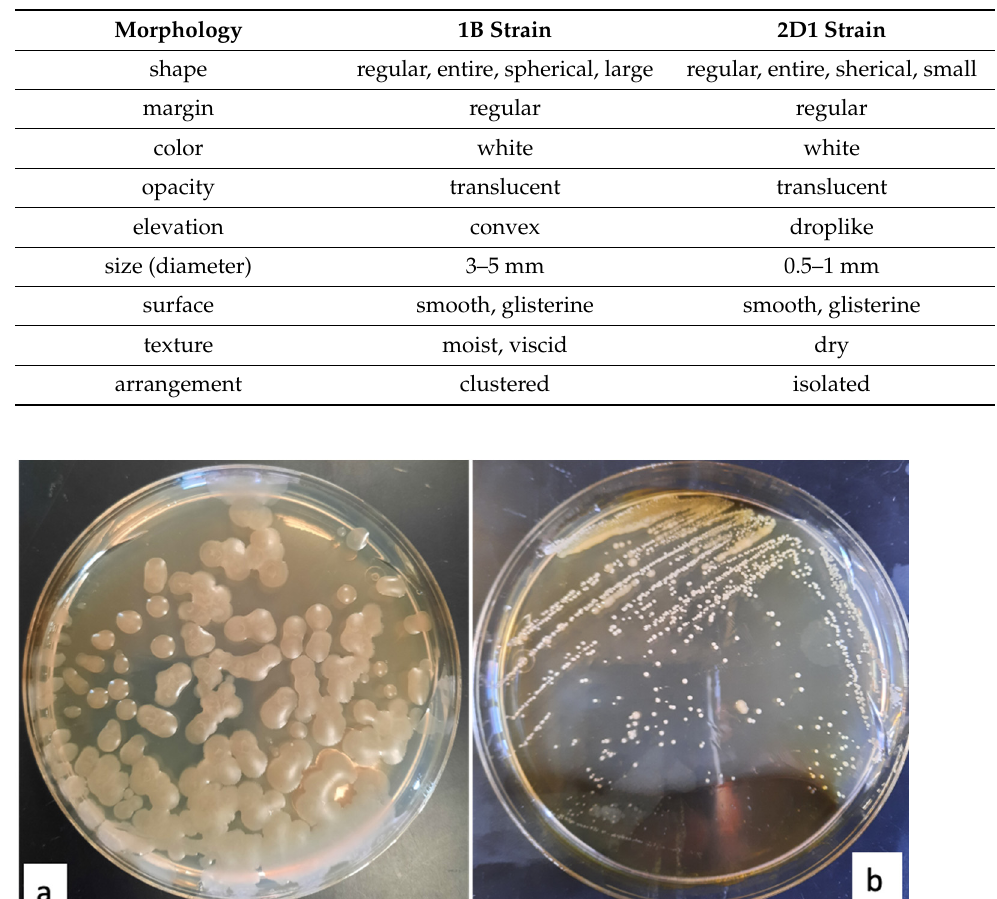
Figure 4. Sudan black staining for PHB granules identification on glass slides; presence of black granules for the two positive PHB producers: 1B ( a ) and 2D1 ( b ).